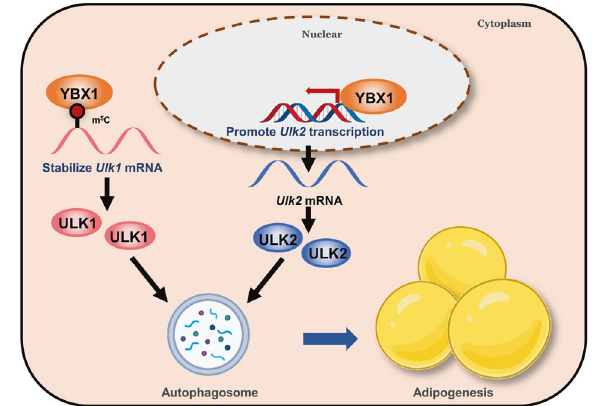
Fig. 8 Proposed model depicting the role and regulation of YBX1 in autophagy and adipogenesis. YBX1 speci fi cally binds to m 5 C-containing Ulk1 transcript and stabilizes its mRNA as an RNA- binding protein. Meanwhile, YBX1 serves as a DNA-binding protein promoting Ulk2 transcription, leading to increased protein abundance of ULK1 and ULK2, thereby enhancing autophagy and